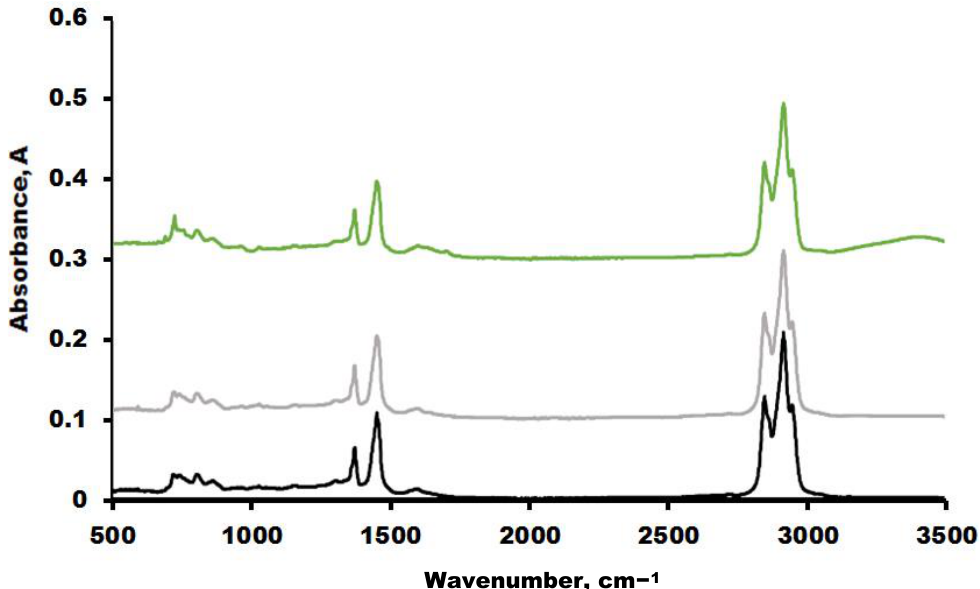
Figure 10. FTIR spectra of heavy oil samples, before and after catalytic and noncatalytic hydrogena- tion of CO 2 .